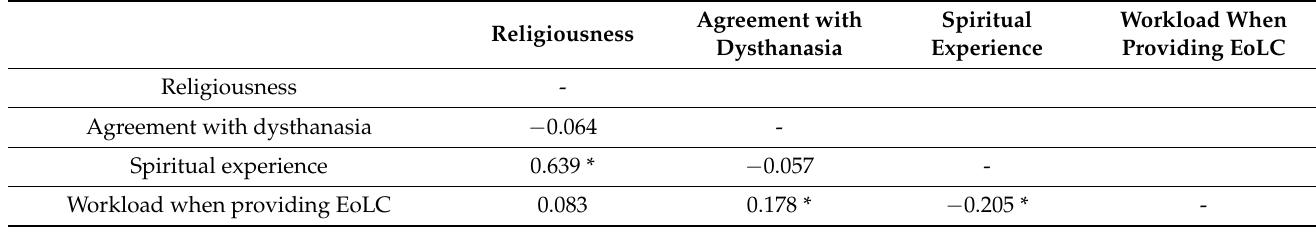
Table 6. Correlation between nurses’ workload when providing EoLC and their attitude toward dysthanasia, religiousness and spiritual experience. Agreement with Spiritual Workload When Religiousness Dysthanasia Experience Providing